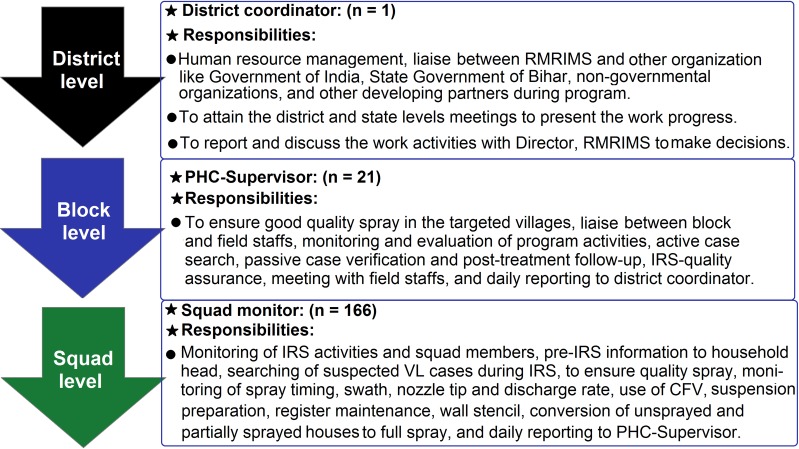
The three-tier monitoring and supervision system adopted by RMRIMS for IRS-based VL vector control program in the Vaishali District, Bihar, India.